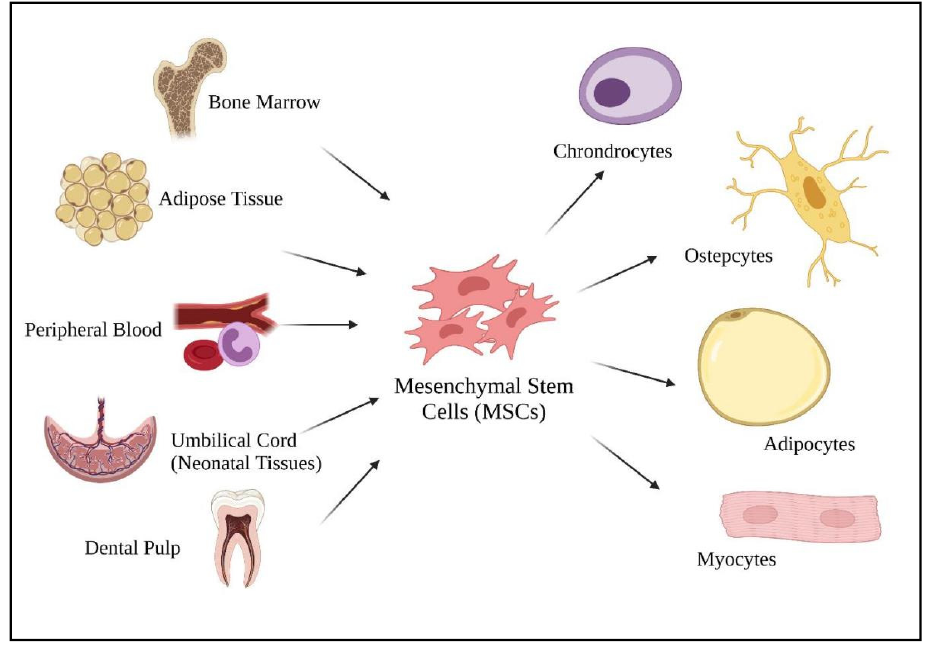
Figure 2. Sources of mesenchymal stem cells and their differentiated lineage. Created with BioRen-